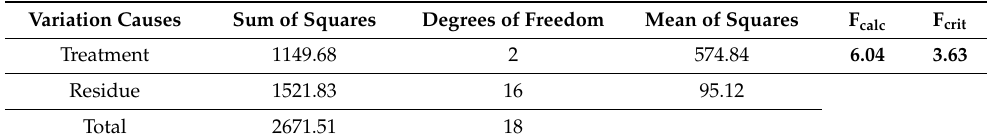
Table 6. ANOVA of the absorbed energy for epoxy composites reinforced with 20, 30, and 40 vol% of arapaima scales tested against 0.22